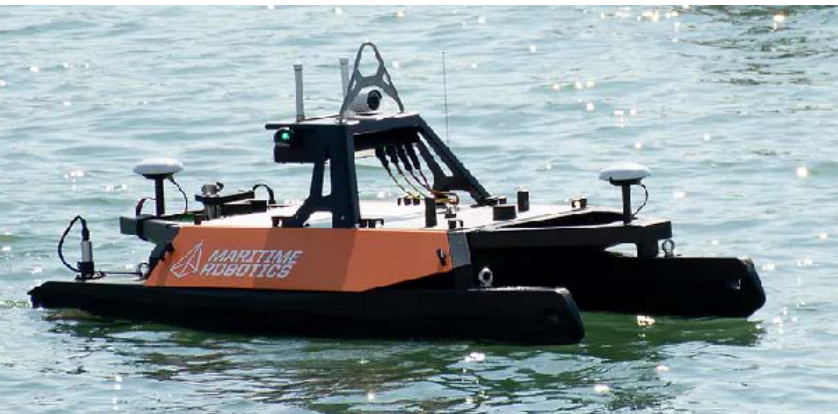
Figure 1. The Maritime Robotics Otter Pro USV (dimensions 2.00